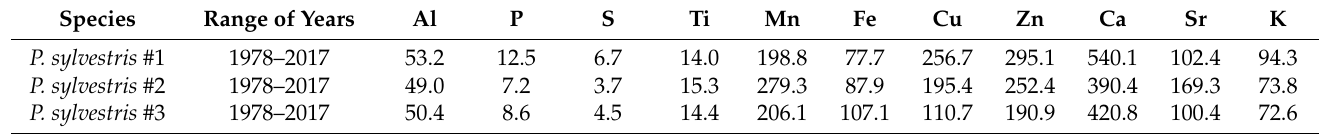
Table A2. Elemental contents in trees under study, mean counts after alcohol